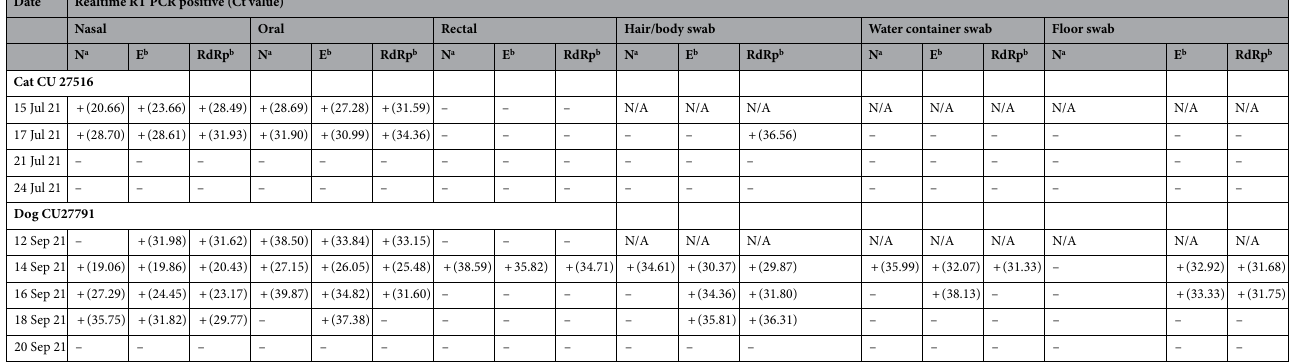
by indirect multispecies ELISA, surrogate virus neutralization test (sVNT) and pseudotyped virus neutralization (pVNT). Our result showed that a cat was positive for SARS-CoV-2 antibodies by indirect ELISA (113%-271%), sVNT (90%-95%) and pVNT (1:640) at day 14 and day 21. While a dog was positive for SARS-CoV-2 antibodies by sVNT (48.81%) at day 24 and pVNT (1:20) at day 9 and day 24 (Table 4). Delta variant of SARS‑CoV‑2 from dog and cat in Thailand. After SARS-CoV-2 detection, we per- formed whole genome sequencing from nasal swab of cat (CU27516; Ct 20.66) and dog (CU27791; Ct 19.06) by using the ARTIC multiplex PCR protocol and MinION sequencing platform (Oxford Nanopore Technolo-